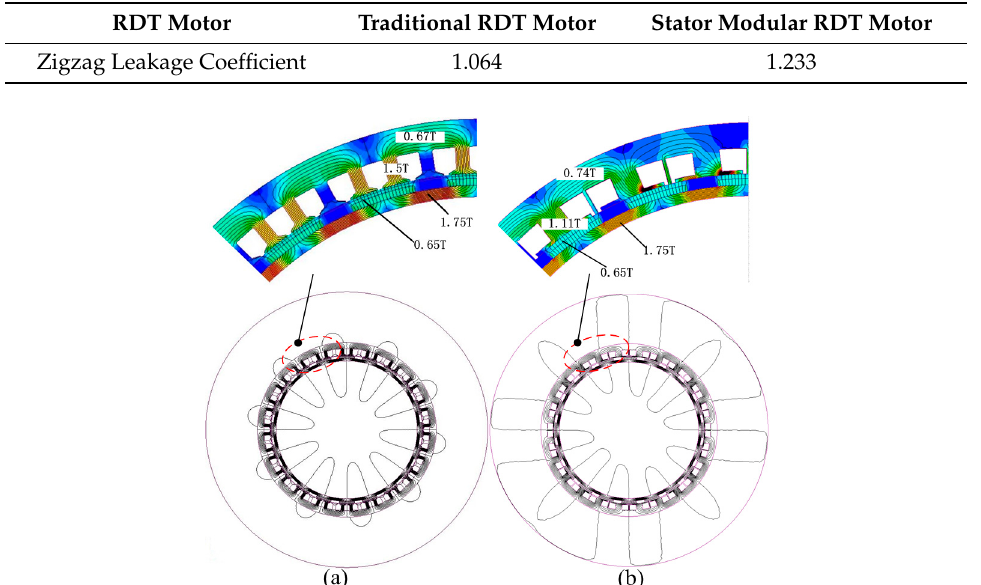
Table 2. Zigzag leakage coefficient.